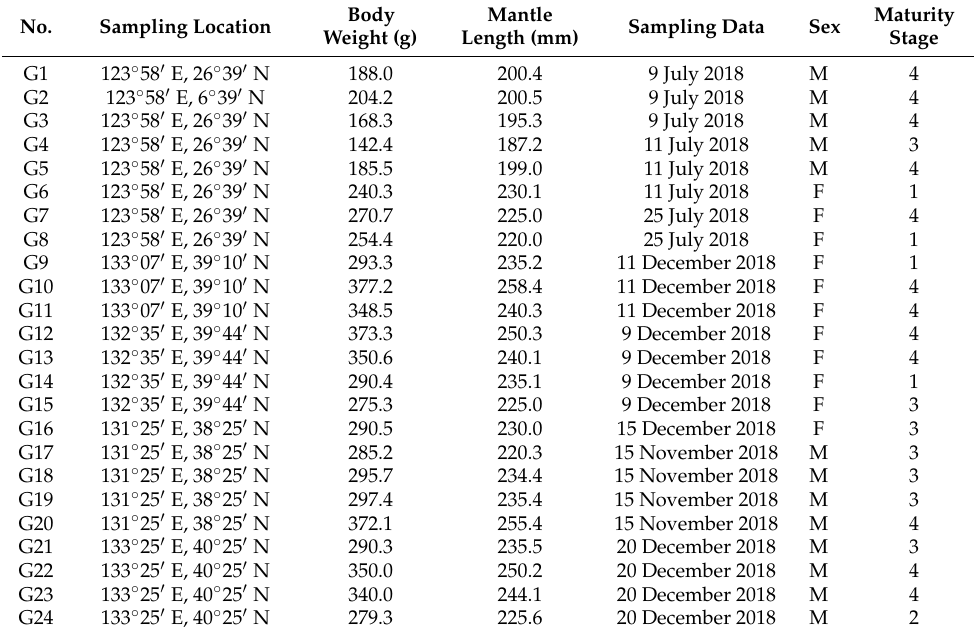
Table 1. Biological parameters of T. pacificus